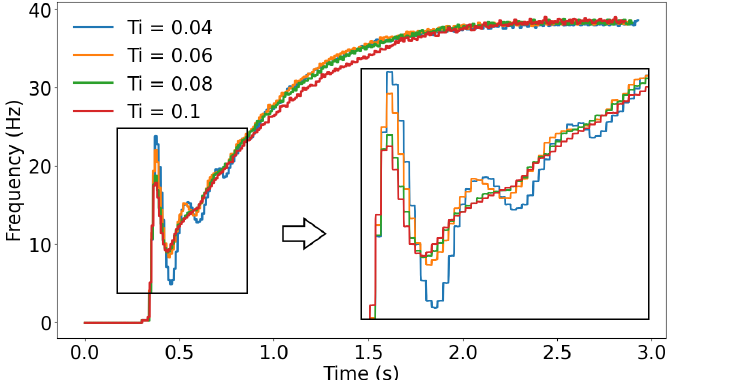
Figure 22. System frequency signal at the starting phase with K p = 2 and different T i .